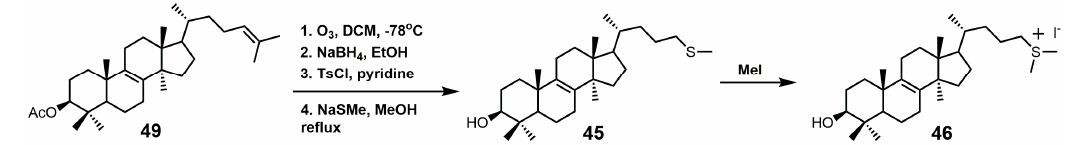
Figure 27. Synthesis of 25-thialanosterol and 25-thialanosterol salt.